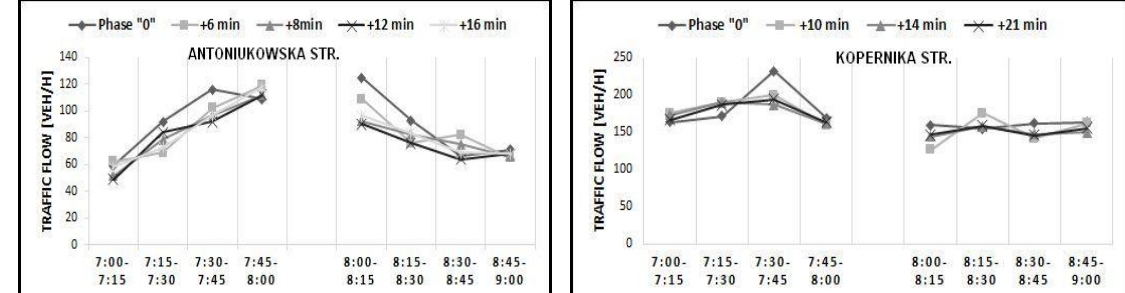
Figure 7. Traffic flow changes in 15-min intervals on main directions.